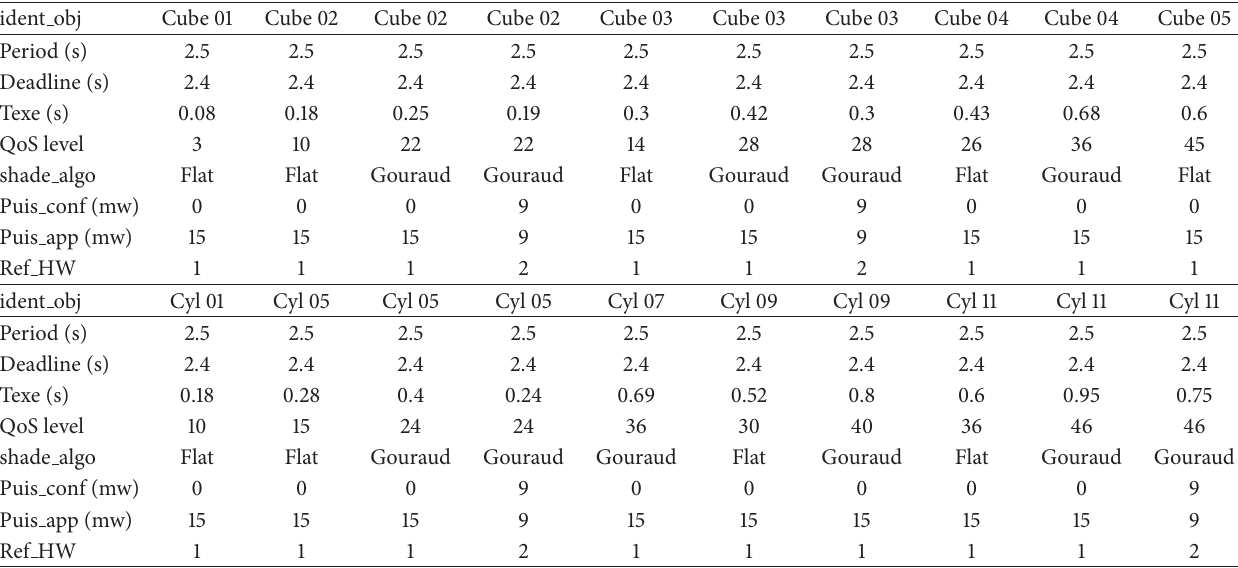
Table 6: Examples of configuration settings for cube and cylinder